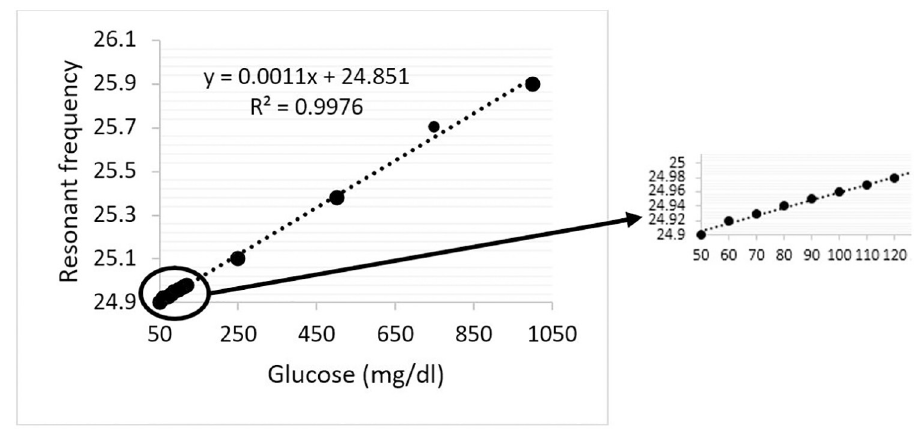
Fig 16. Regression